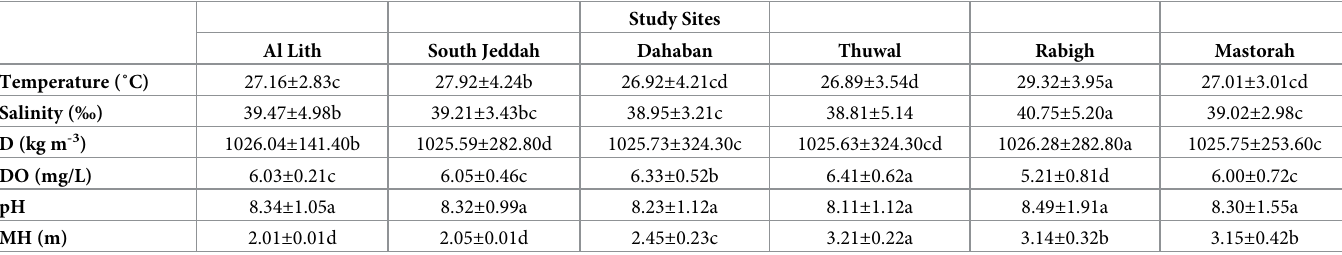
Table 2. Mean physicochemical properties of seawater and mangrove heights at 6 sites on the coast of the central Red Sea, Saudi Arabia.